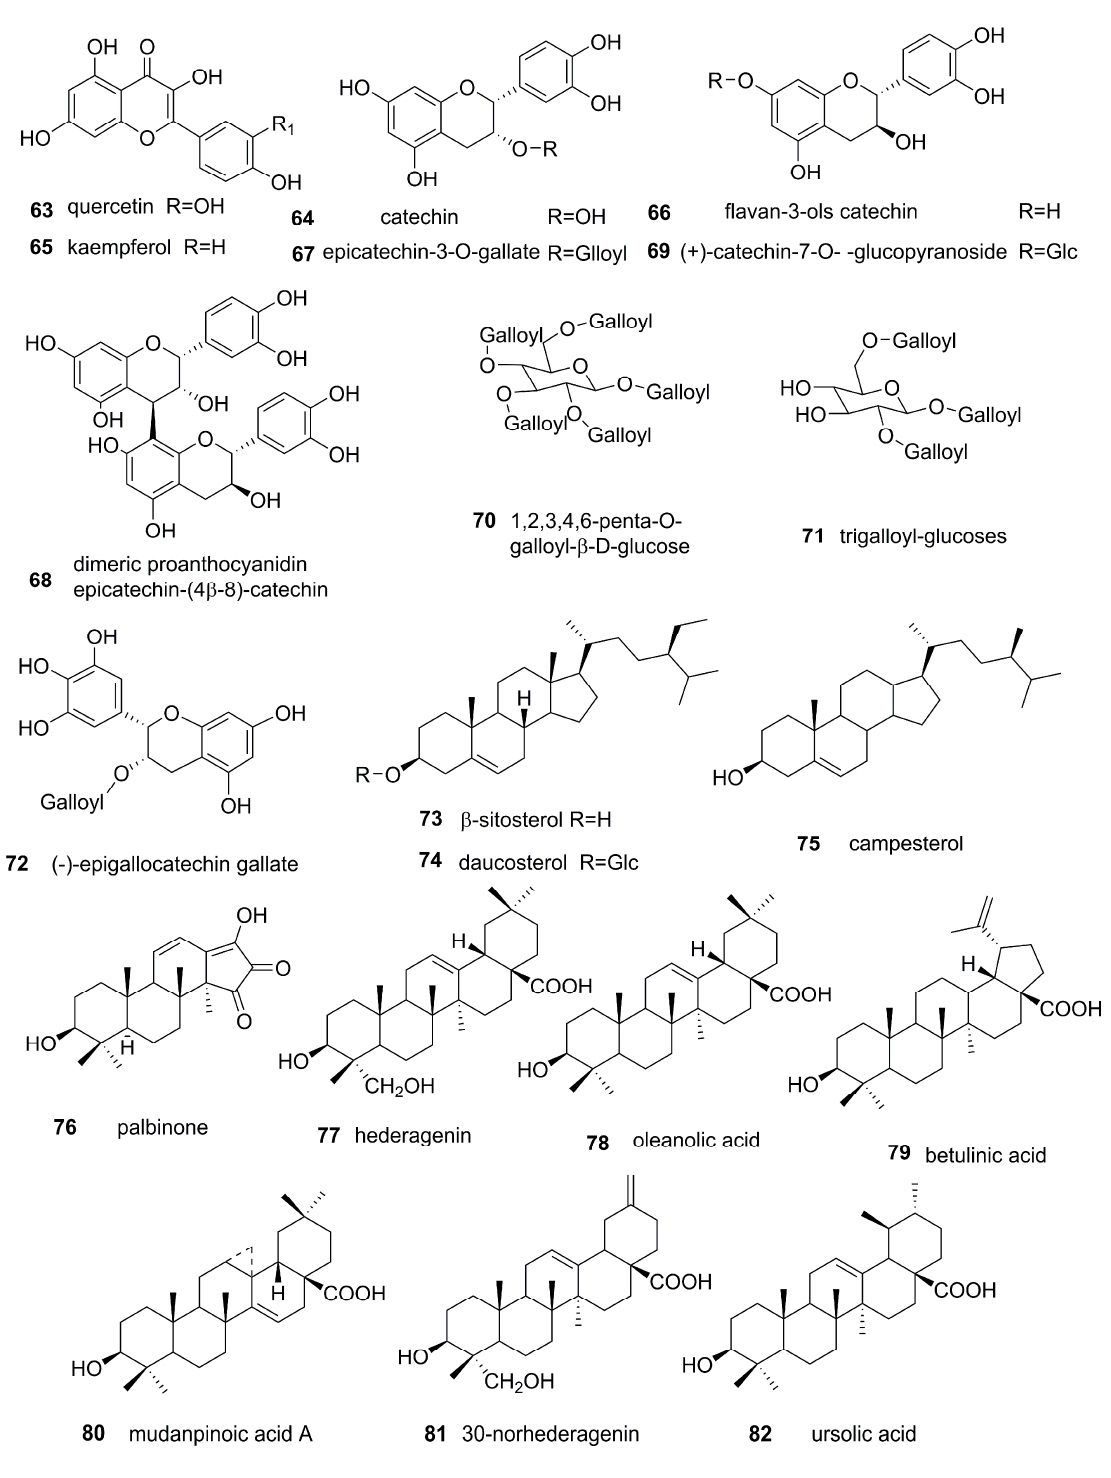
Figure 2. Cont. Figure 2.